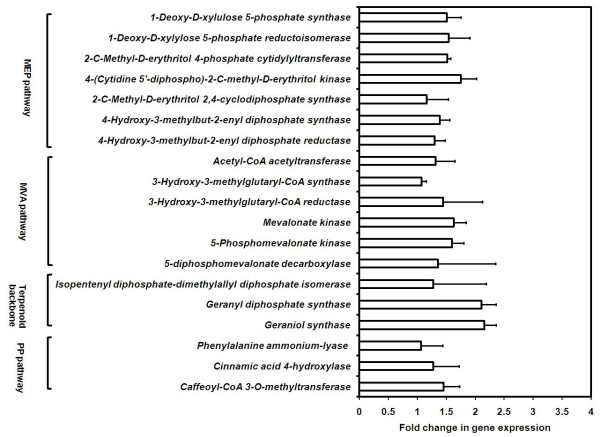
Effect of temperature on expression of 19 genes of mevalonate (MVA), 2-C-methyl-D-erythritol 4-phosphate (MEP) and phenylpropanoid (PP) pathways (pathways associated with picrosides biosynthesis) as analysed by reverse transcriptase-polymerase chain reaction (RT-PCR). Total RNAs were extracted from the leaf tissue of plants exposed to 15°C and 25°C and changes in the abundance of transcripts were analyzed by RT-PCR using gene specific primers. Data shows fold increase in the transcript levels of putative genes at 15°C as quantified by measuring integrated density value (IDV) of amplicon. Data represents average of three separate biological replicates with error bars as standard deviation. Expression of 26 s rRNA was used as control [92]. Additional file 16 details on primers and the PCR conditions used in RT-PCR.